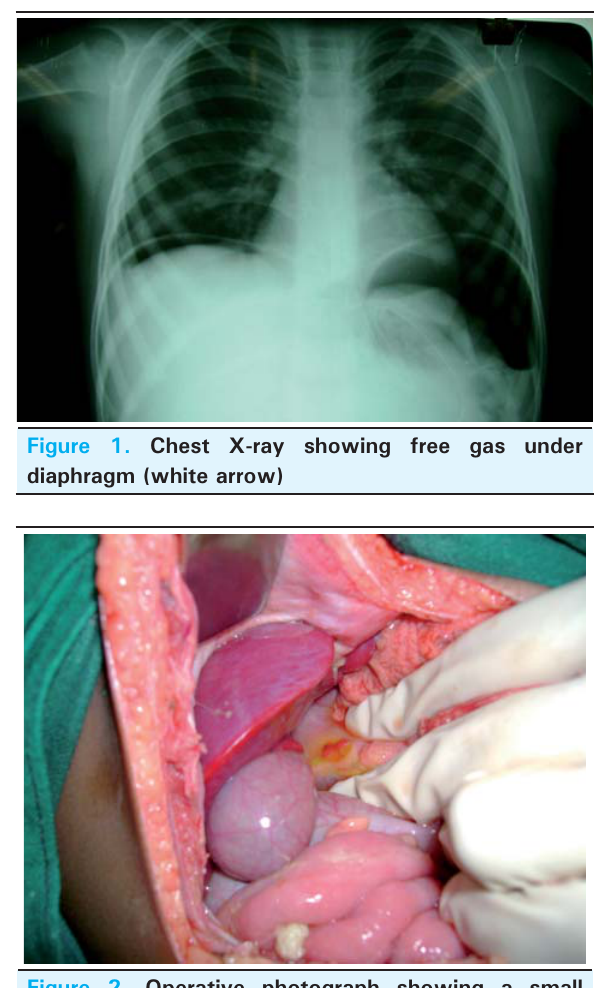
Figure 2. Operative photograph showing a small perforation in the anterior wall of the fi rst part of duodenum (black